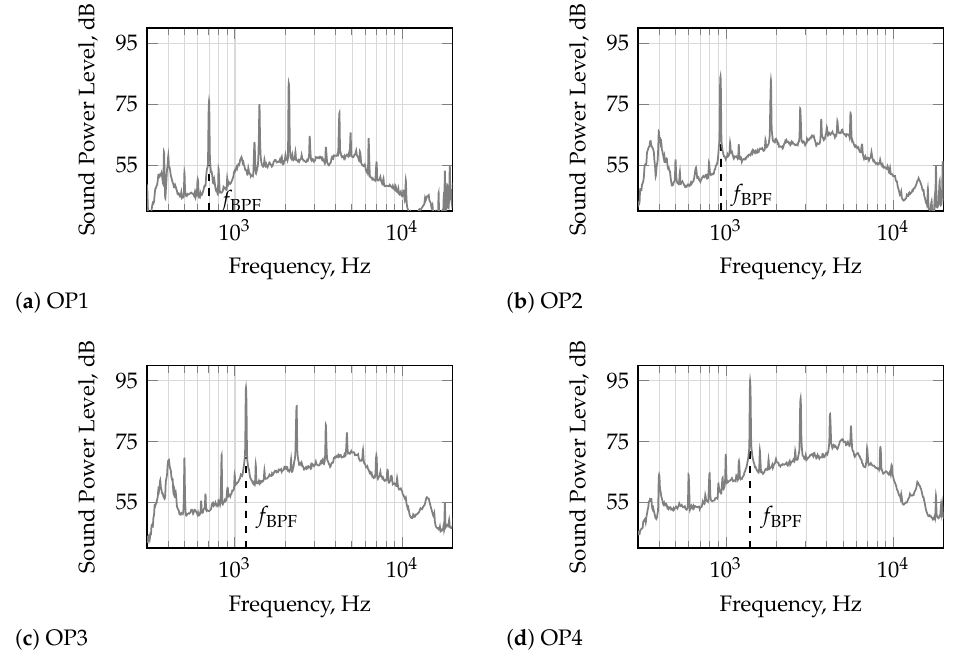
Figure 7. Narrowband L W,A at different operating points relative to the highest narrowband sound power level in the observed operating